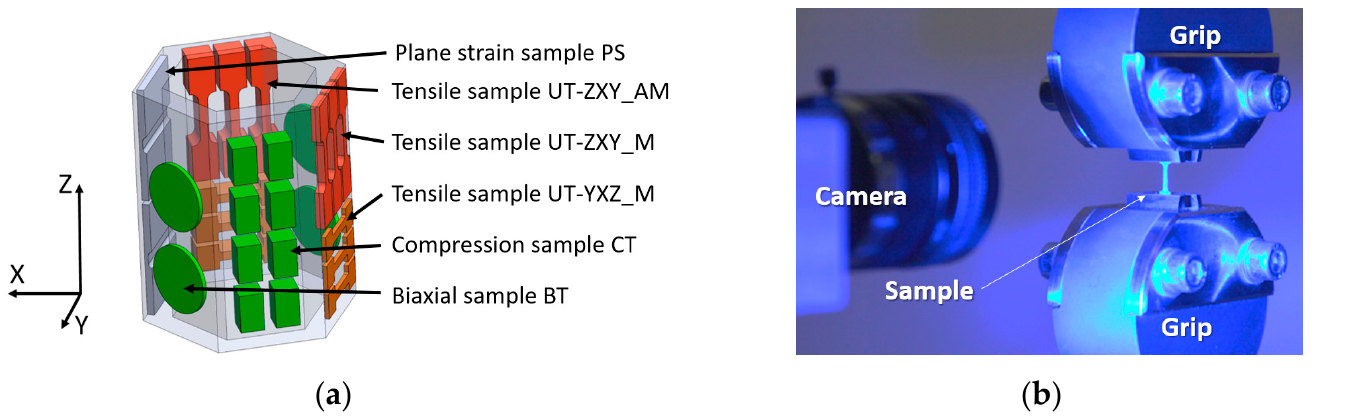
Figure 10. ( a ) Cutting plan of DED-processed honeycomb structure with uniaxial, plane strain and biaxial tension and compression specimen geometries included ( b ) Miniaturized tensile testing setup with miniaturized sample gripped and optical (DIC) deformation tracking. Table 2. Mechanical testing—sample portfolio including loading mode, surface state and thickness, orientation and designation of the samples.